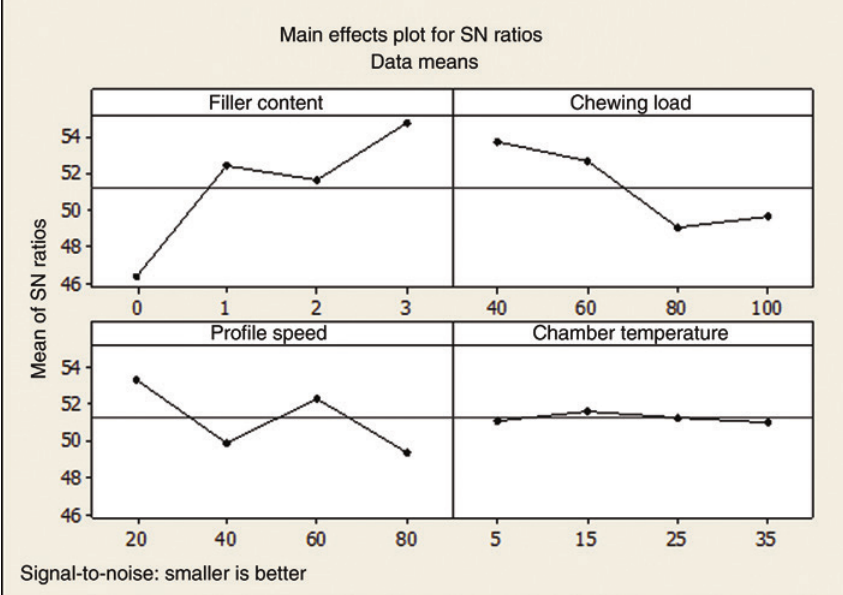
Figure 9: Effect of control factors on the wear rate of dental composites.